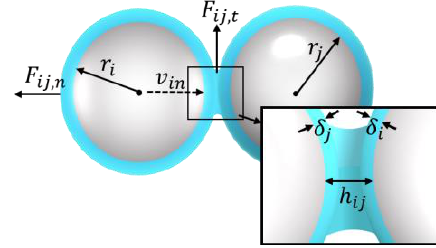
Fig. 1 . Schematic of two spheres